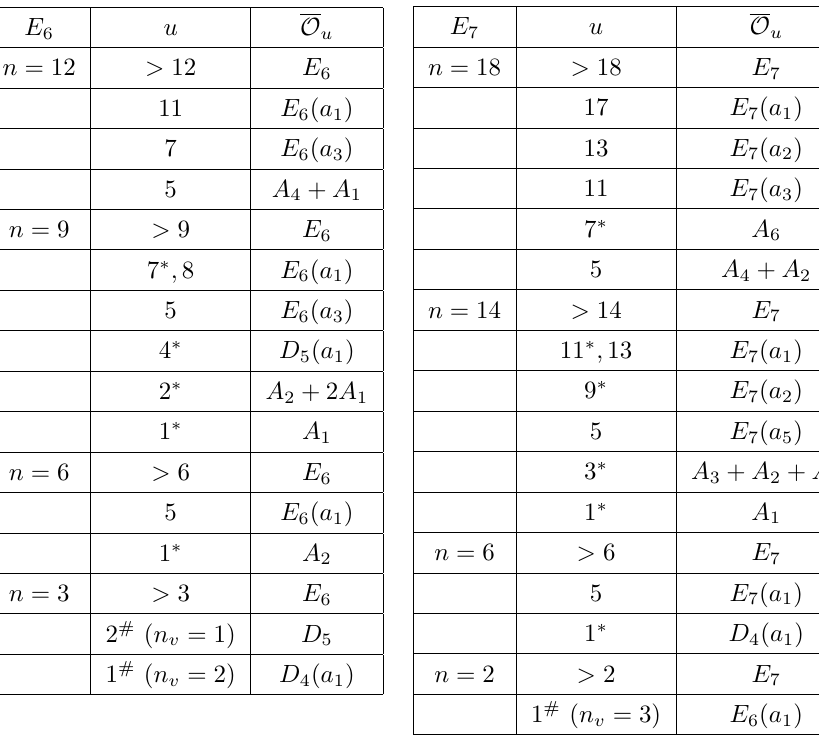
Table 20 . Associated variety for E 6 and E 7 type AKM V − h ∨ + n u ( g ) . The one with star implies that theory has a pure Higgs branch. The one with # implies that the IR theory has free vector multiplets in the Higgs branch, and n is the number of free vector multiplets. The one with ∗ v